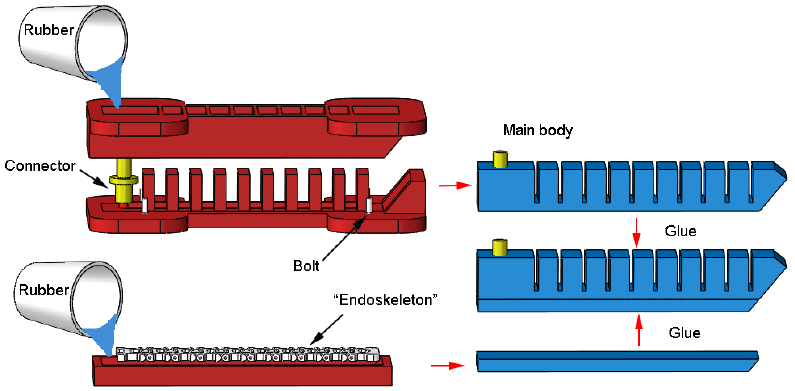
Figure 3. Fabrication process of the gripper finger with endoskeleton.